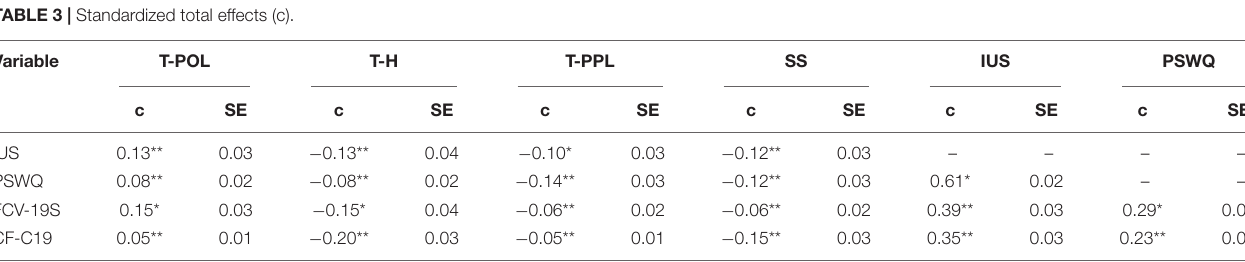
FIGURE 2 | Model of associations between social and cognitive variables and COVID-19 related anxiety and worry. Correlations between independent variables are given in Table 2 , thus are not presented here. Path coefficients are standardised regression coefficients. R 2 values for endogenous variables are presented next to the corner of each variable. e1, e2, e3, and e4 are residuals. * p < 0.05; ** p < 0.01; *** p < 0.001. TABLE 3 | Standardized total effects (c).